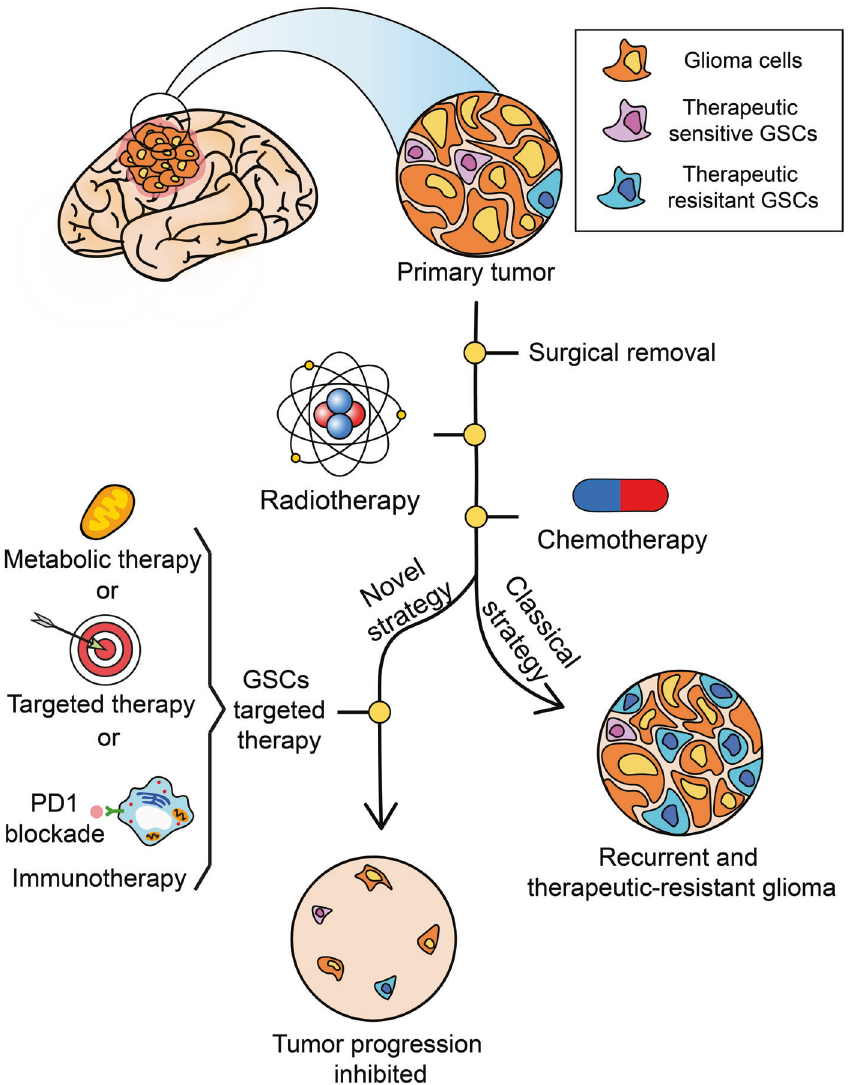
Fig. 5 Therapy resistant GSCs like MES GSCs can survive from a classical strategy like chemo- or radio-therapy. In the meantime, the combination of GSCs targeted therapy and classical strategy may improve treatment ef fi